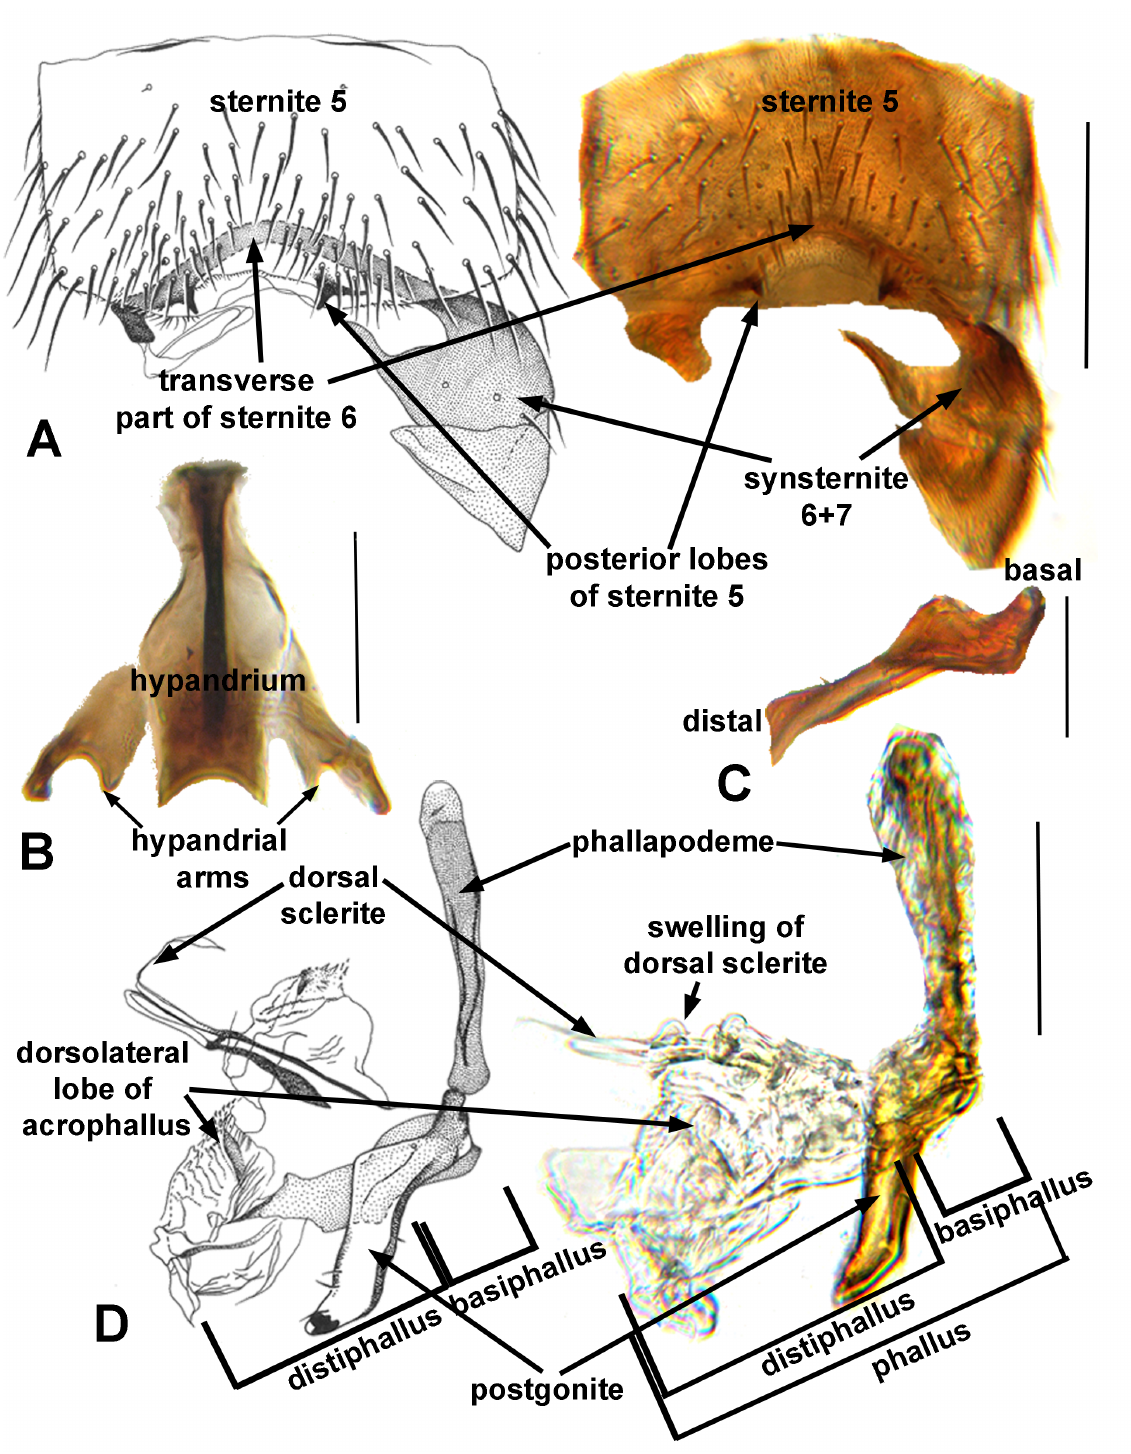
Fig. 3 . Male morphology. A . Rudolfina tumida sp. nov., sternite 5, ventral view (debu01086083). B . R. exuberata sp. nov., hypandrium (debu00242299). C . R. cavernicola Marshall & Fitzgerald, 1997, postgonite, lateral view (debu01086077). D . R. tumida sp. nov., phallus (including the basiphallus and distiphallus), postgonite and phallapodeme, lateral view (debu01086083). Scale bars: A = 0.15 mm; B = 0.05 mm; C = 0.05 mm; D = 0.10